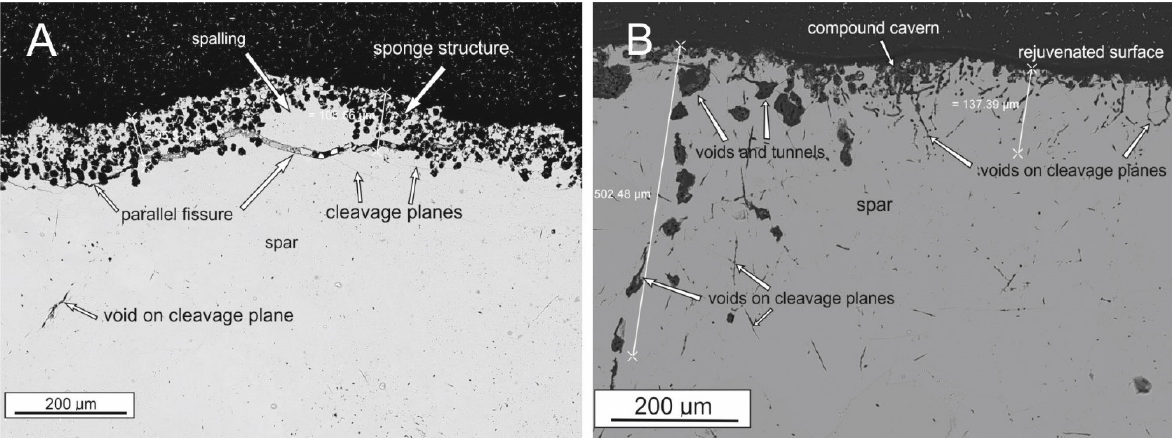
spalling (images from FE-SEM).